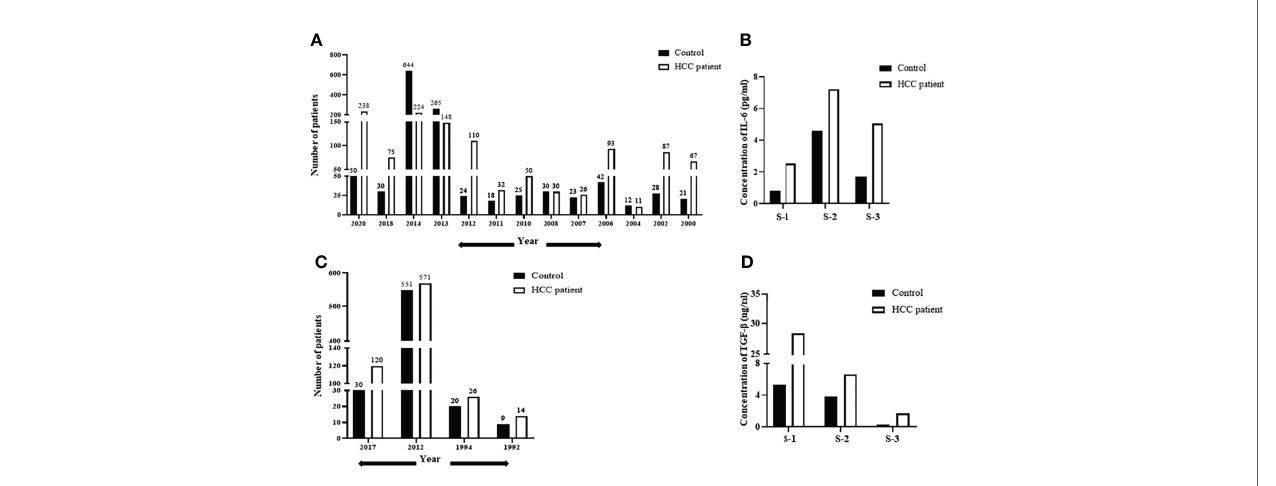
FIGURE 1 | De-regulation of IL-6 and TGF- b in HCC patient datasets. (A) A year-wise timeline analysis showing IL-6 levels in serum/plasma of HCC patients compared to those in healthy control. (B) Analysis of concentration of IL-6 (pg/ml) in HCC patients from three independent studies compared to that in healthy control. (C) A year-wise timeline analysis showing TGF- b levels in serum/plasma of HCC patients compared to those in healthy control. (D) Analysis of concentration of TGF- b levels (ng/ml) in HCC patients compared to that in healthy control from three independent